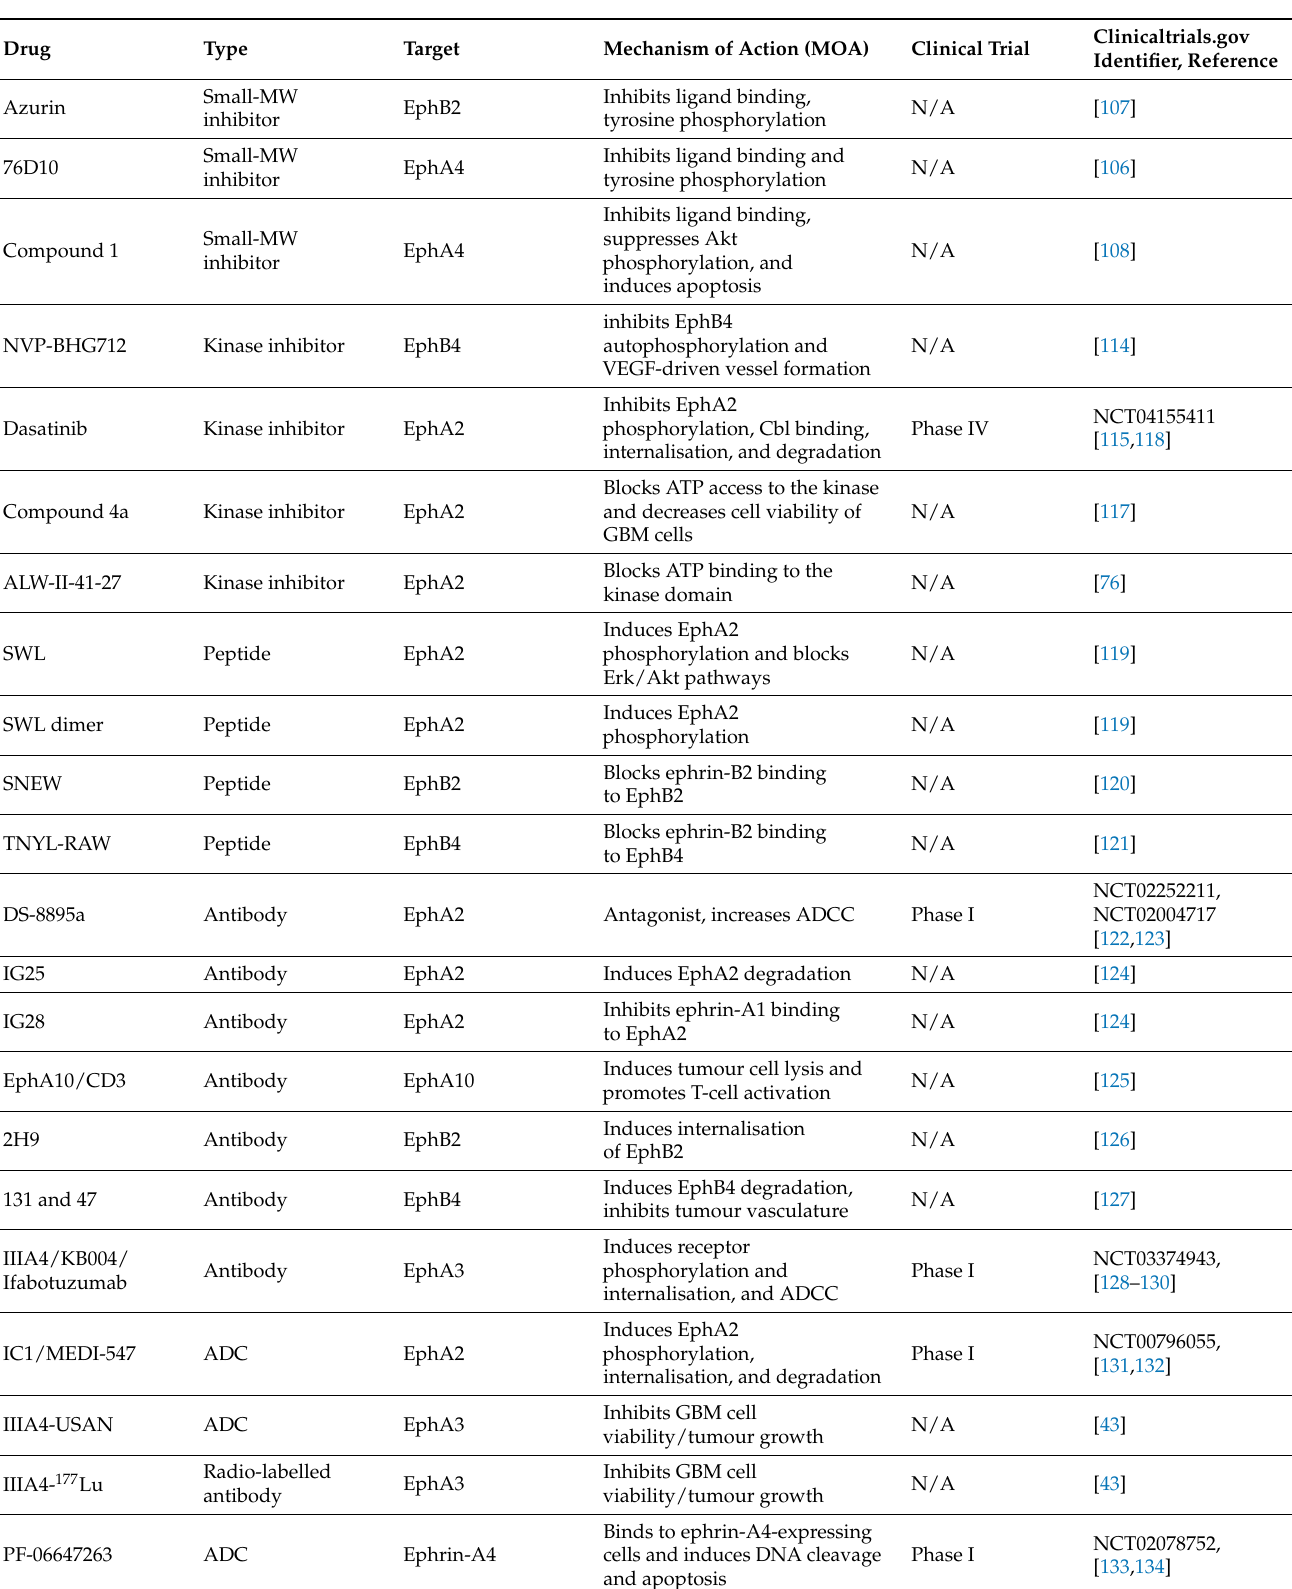
Table 2. Various small-molecule inhibitors/peptides/antibodies/ADCs to target Eph–ephrin recep- tors and their clinical trial status. ADC = Antibody–drug conjugate; ADCC = Antibody-dependent cellular cytotoxicity; IG = Immunoglobulin; MW = Molecular weight; N/A = Not applicable; VEGF = Vascular endothelial growth